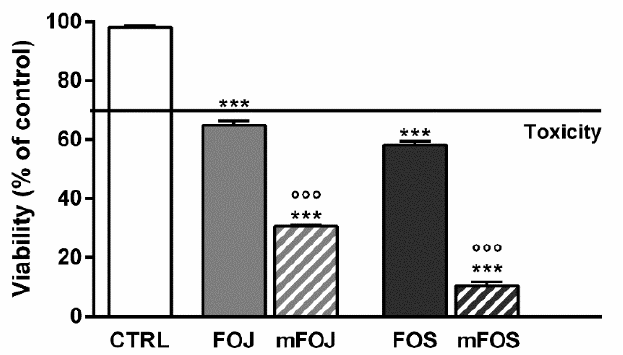
Figure 4. Cytotoxicity of 50 µ g/mL FOJ and FOS (organic extracts from Felina 32 hemp inflorescences collected in June and September respectively) and the corresponding cocktails mFOJ and mFOS (containing nonintoxicating phytocannabinoids and caryophyllane sesquiterpenes at the same concentrations found in 50 µg/mL FOJ and FOS) in MDA-MB-468 breast cancer cells. Data are expressed as mean ± SEM of at least three independent experiments with three technical replicates ( n = 9); *** p < 0.001, significant difference respect to the control; °°° p < 0.001, significant difference respect to Felina 32 organic extracts (ANOVA + Dunnett’s Multiple Comparison PostTest).